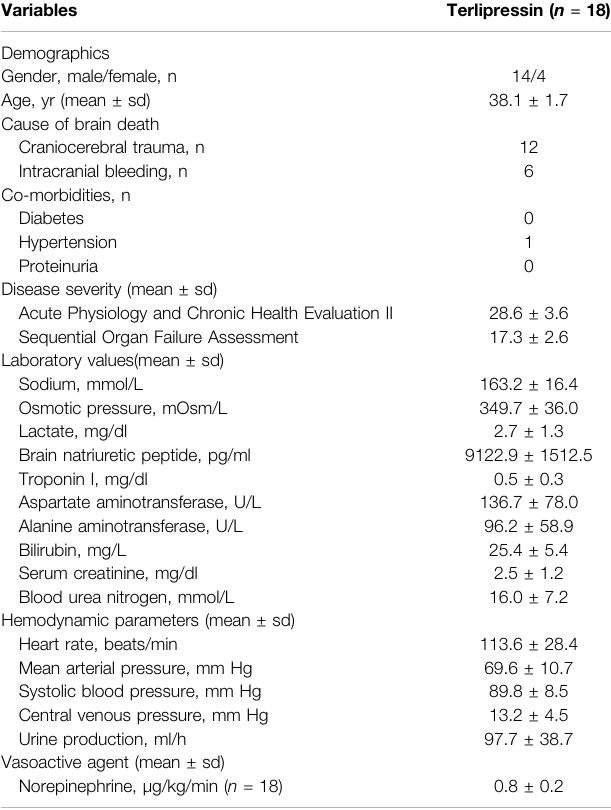
TABLE 1 | Donor baseline characteristicsby terlipressin